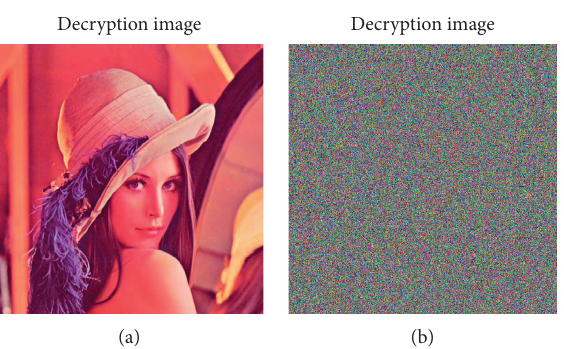
Figure 17: Decryption images. (a) Correct key decryption image, and (b) decrypted images with a small change in y